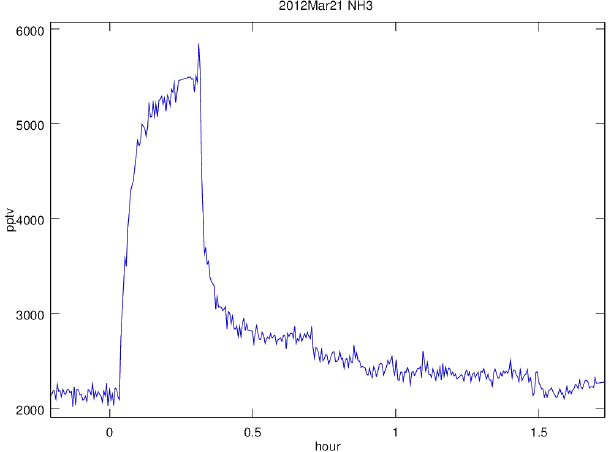
Figure 2. NH 3 mixing ratio measured with AmPMS plotted versus time. Addition of NH 3 at 0.05h followed by its removal at 0.35h. Gross signals were used to calculate mixing ratio using S typ ; no background subtraction was done. The NH 3 was introduced into the sample flow from a 30pmols − 1 NH 3 permeation tube with sin- gle stage dilution. AmPMS was in its original configuration where sample gas first passes through a three-way solenoid valve.